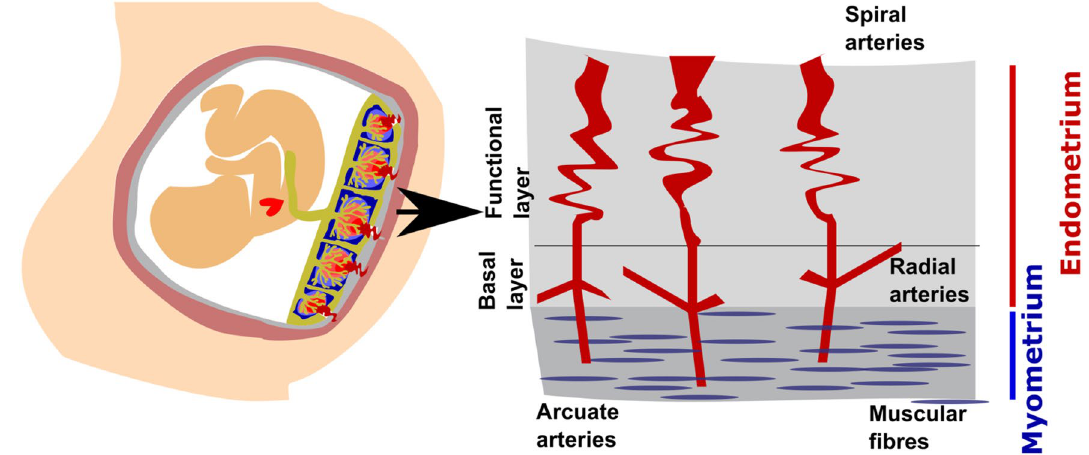
Figure 1. Schemata of the uterus and placental bed with a focus on the endometrium and